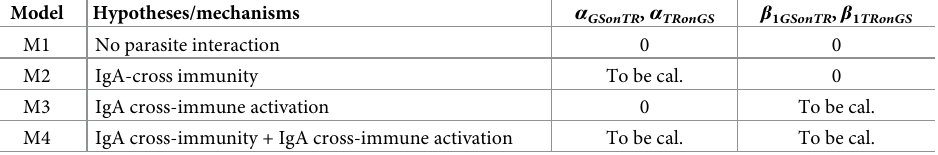
Table 4. Tested hypotheses and related mechanisms for the competing models of helminths interaction in dual infection. The parameters